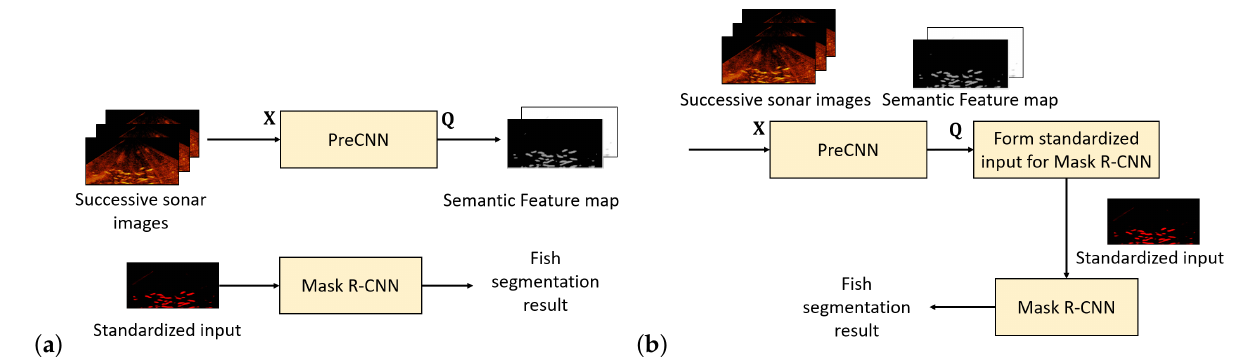
Figure 3. The flow of Mask R-CNN+PreCNN: ( a ) the flow of training PreCNN and fine-tuning Mask R-CNN; ( b ) the flow of fish